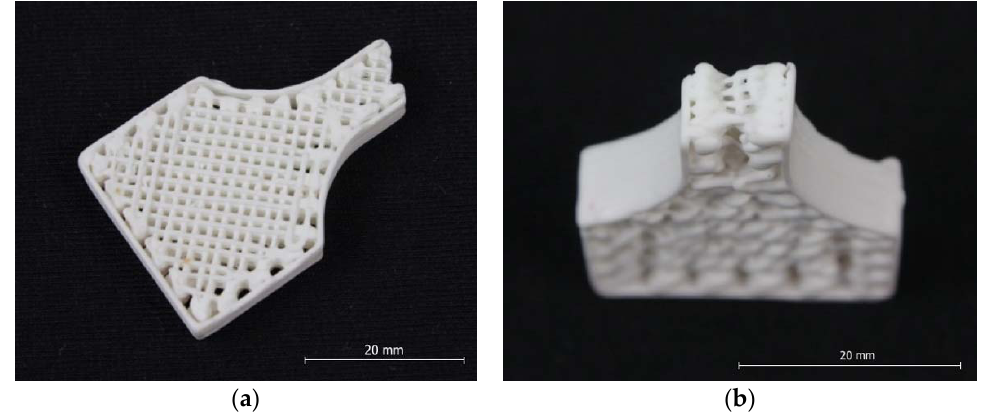
Figure 7. Ceramic samples fabricated by three-dimensional (3D) printing with a fill factor of 50%: ( a ) view from above and ( b ) side view.